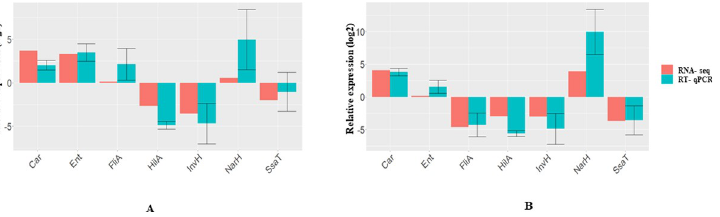
Fig 8. Validation of the RNAseq data for selected genes by RT-qPCR. RT-qPCR data confirmed the expression trends observed in the RNA-seq data for seven genes in KCOH 2 and 4 mg/mL compared to control, where rpoD used as a reference